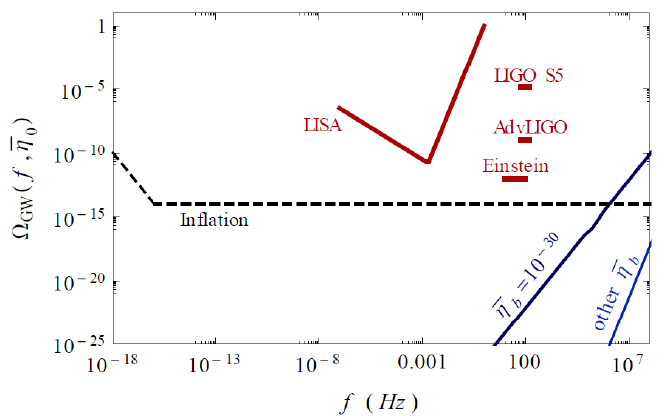
Figure 1. The figure shows a comparison of our results, labeled by ¯ η b (the smaller this parameter the bigger is the energy scale of the bounce, and the value 10 − 30 is just two orders of magnitude away from the Planck scale) with experimental sensitivities of LIGO’s 5th run, Advanced LIGO, and the forthcoming LISA and Einstein Telescope and a prediction of the upper limits on the spectrum of primordial gravitational waves generated in inflationary